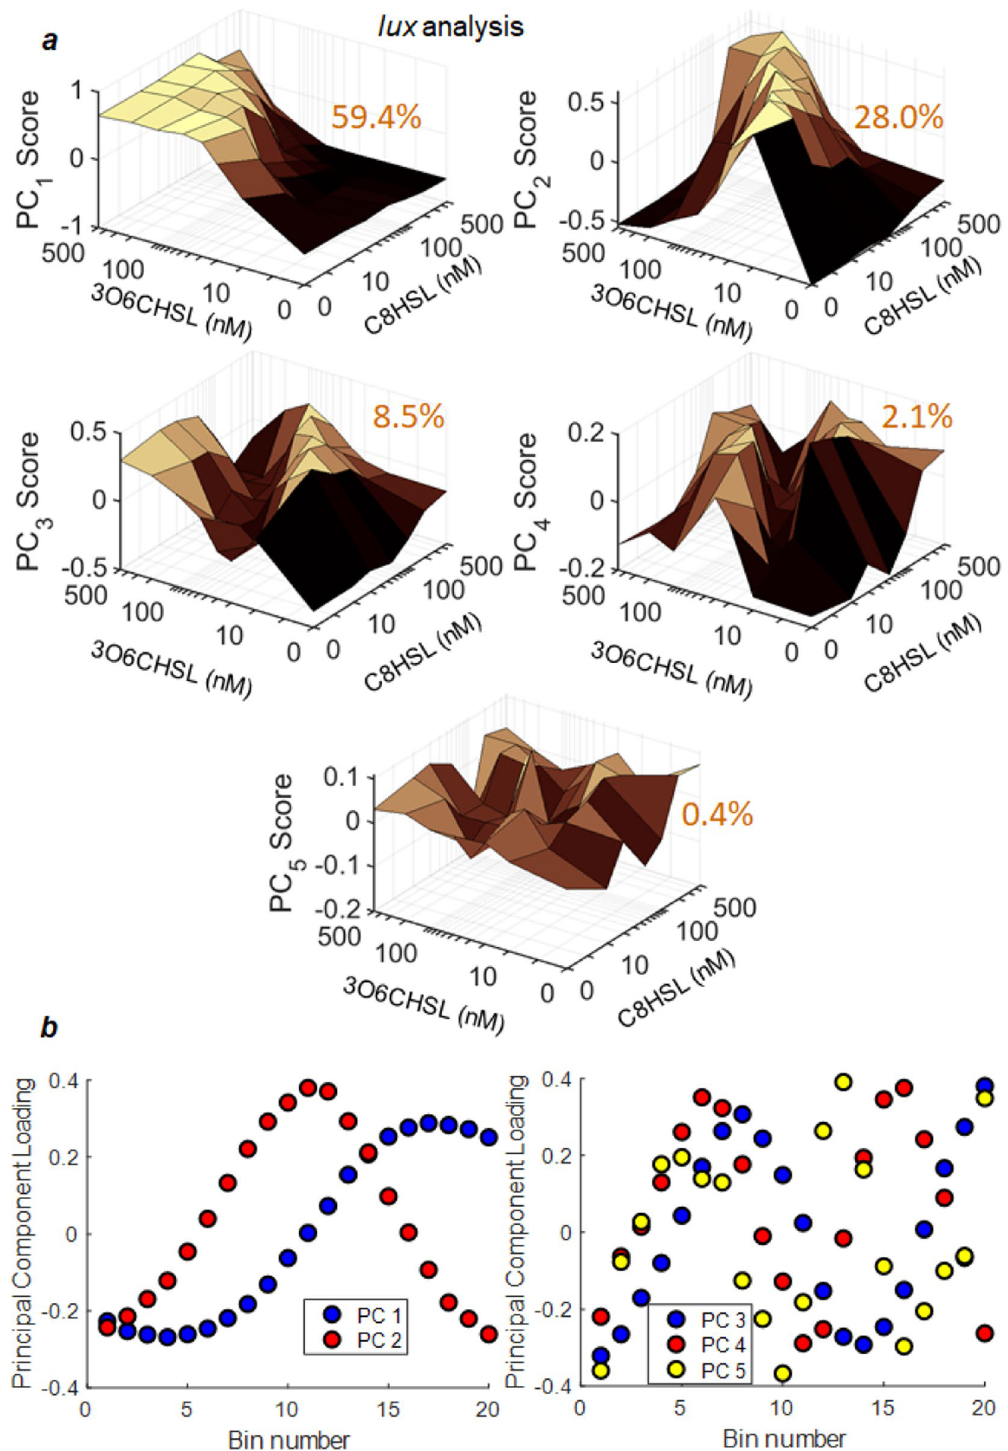
Figure 5. Principal component analysis (PCA) of the set of lux reporter fluorescence histograms, collected under 56 combinations of C8HSL and 3OC6HSL concentrations. The same analysis was performed as for the qrr reporter data. The PCA of the complete set of histograms provides (a) scores for each principal component as a function of HSL input condition, and (b) loadings associated with each PCA component. The percentage of data variance explained by each PCA component is indicated on the panel. For the lux data, the first five PCA components only are shown; these together account for 98.4% of the variance in the dataset (see